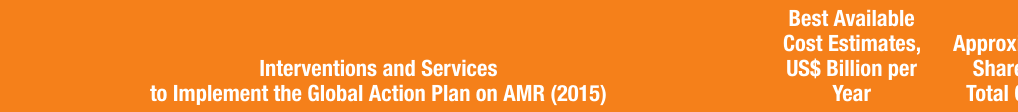
Interventions and Services to Implement the Global Action Plan on AMR